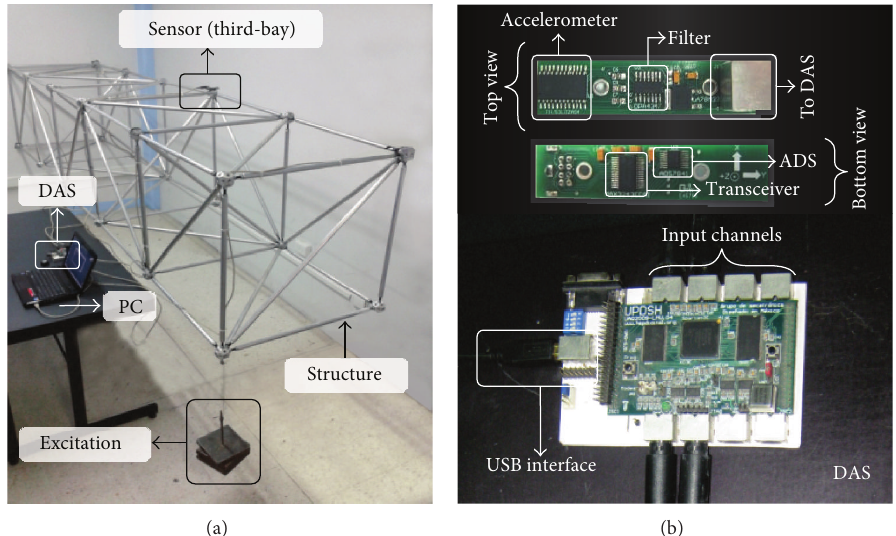
Figure 5: Experimental setup: (a) overall system and (b) triaxial accelerometer and data acquisition system.